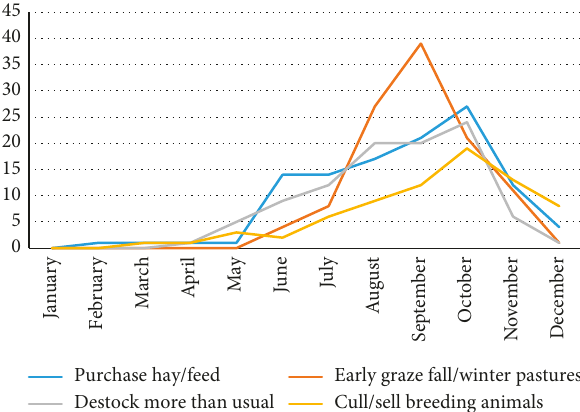
Figure 2: Number of respondents who took each action in response to drought conditions in 2016 by